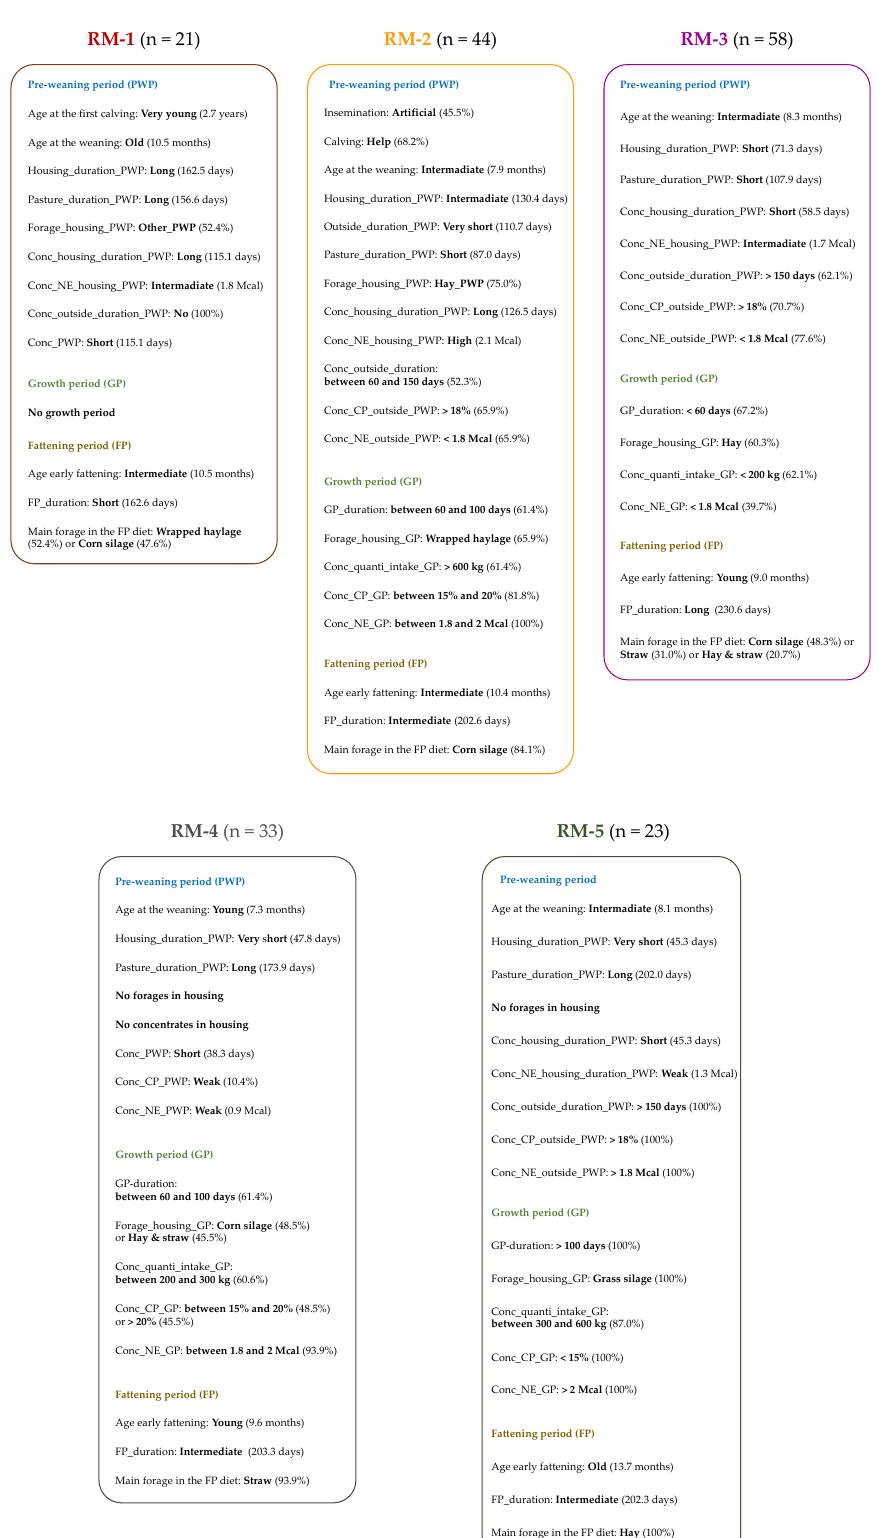
Figure 2. Description of the five rearing managements (RMs) applied throughout young bulls’ life, with a focus on the rearing factors characterizing the most each RM, as described in Tables 3–5.